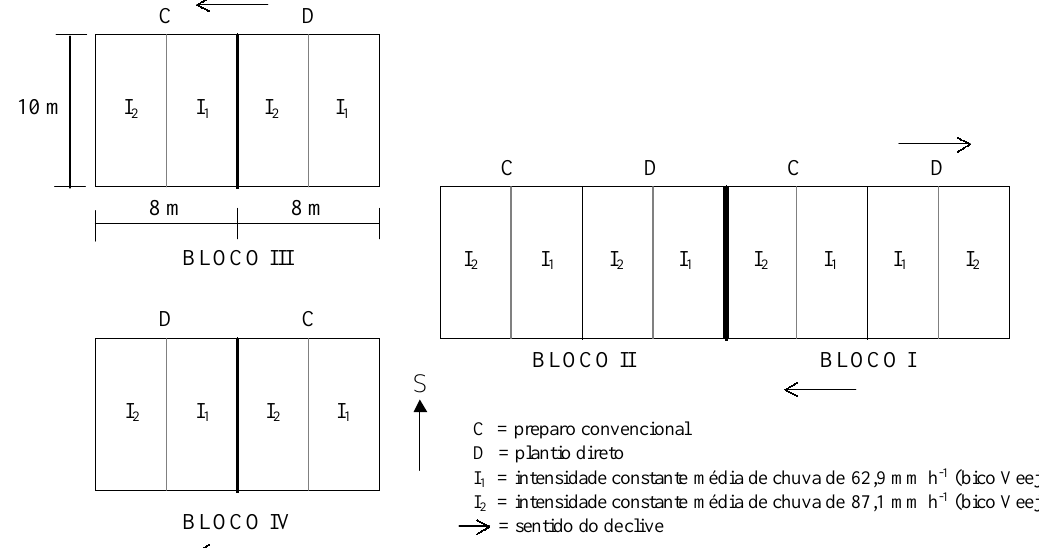
Figura 1. Esquema do delineamento